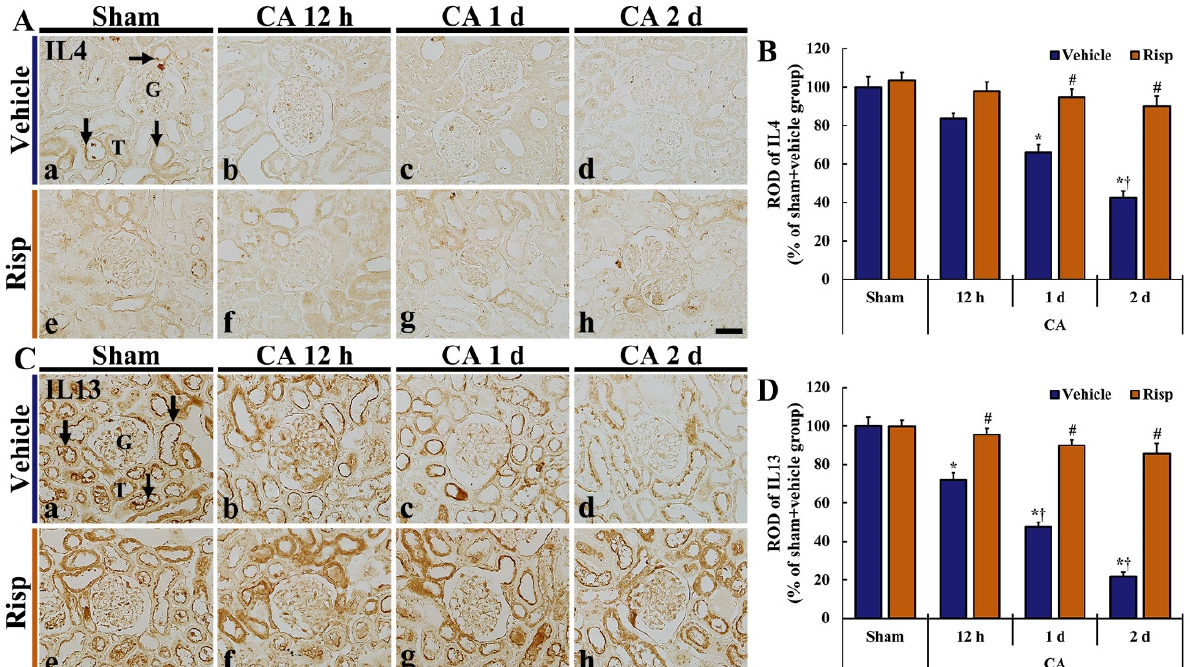
Figure 6. ( A , C ) Immunohistochemical staining of IL4 ( A ) and IL13 ( C ) in the kidney obtained from the Sham-vehicle ( a ), CA-vehicle ( b – d ), Sham-Risp ( e ) and CA-Risp ( f – h ) groups at 12 h, one day and two days after CA/ROSC. In the CA-vehicle group, IL4 and IL13 immunoreactivities (arrows) are gradually decreased after CA/CPR: two days after CA/ROSC, IL4 immunoreactivity is hardly shown and IL13 immunoreactivity is weak. However, IL4 and IL13 immunoreactivities of the CA-Risp group are maintained after CA/ROSC. G, glomerulus; T, tubule. Scale bar = 100 μm. (B and D) RODs of IL4 ( B ) and IL13 ( D ) immunoreactivities. The bars indicate the means ± SEM ( n = 7, respectively; * p < 0.05 vs. Sham-vehicle group; # p < 0.05 vs. CA-vehicle group; † p < 0.05 vs. pre-time point of corresponding group).